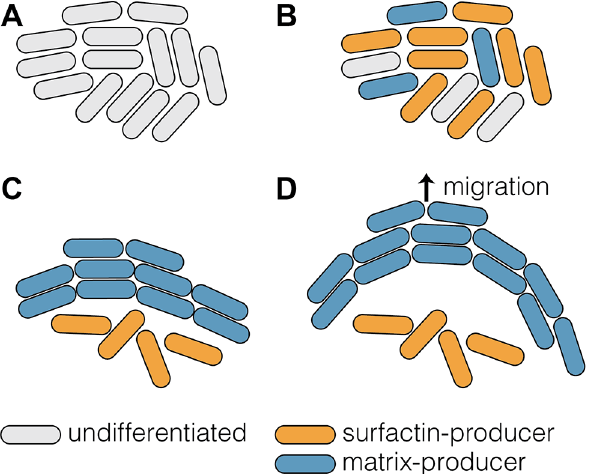
Fig 1. Collective behavior through the spatial organization of differentiated cells. (A) Initially cells form a homogenous population. (B) Differentiation: cells start to differentiate into surfactin- (orange) and matrix- (blue) producing cells. The two cell types perform two complementary and essential tasks, resulting in a division of labor. (C) Spatial organization: the matrix-producing cells form van Gogh bundles, consisting of highly aligned and interconnected cells. Surfactin-producing cells are excluded from the bundles and have no particular spatial arrangement. (D) Collective behavior: growth of cells in the van Gogh bundles leads to buckling of these bundles, resulting in colony expansion. The buckling and resulting expansion depend critically on the presence of the two cell types and on their spatial